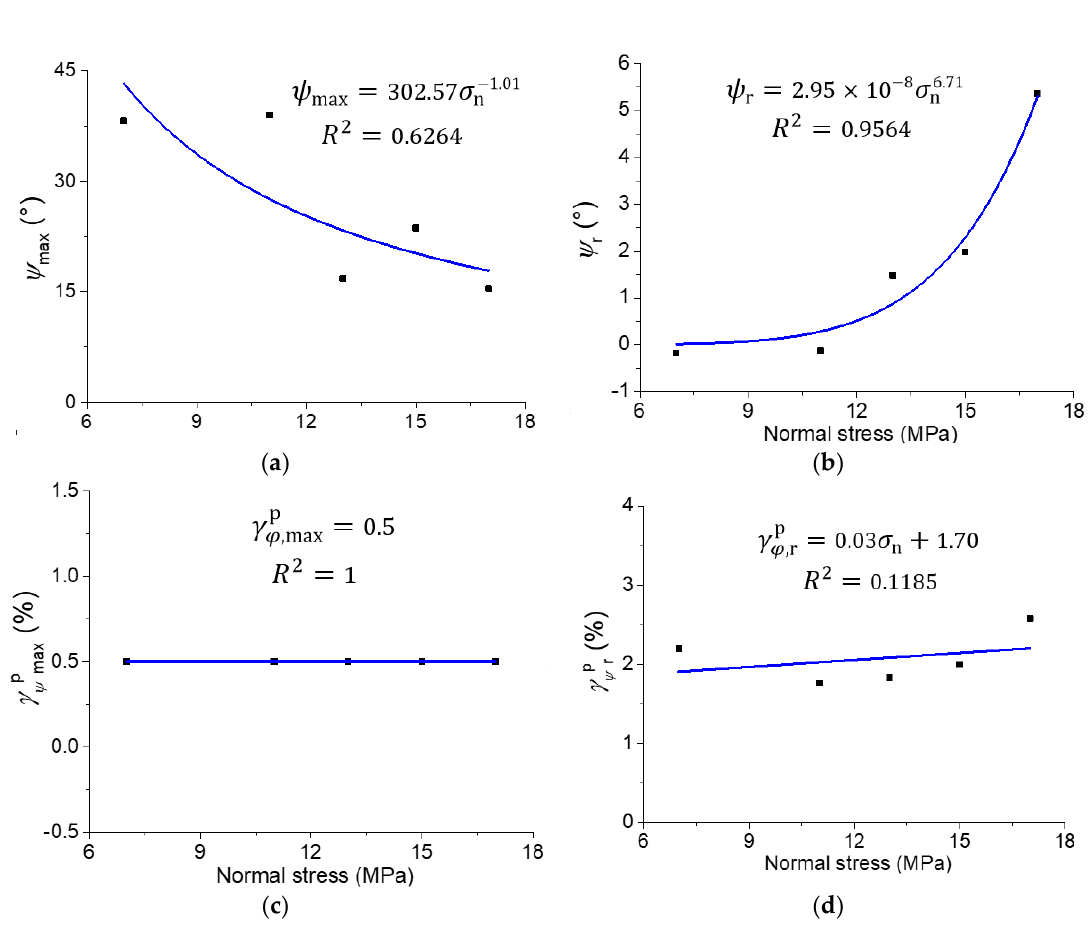
Figure 10. Variation of fitting coefficients ( a ) 𝜓 max , ( b ) 𝜓 r , ( c ) 𝛾 𝜑,maxp , and ( d ) 𝛾 𝜑,rp at different normal stresses.